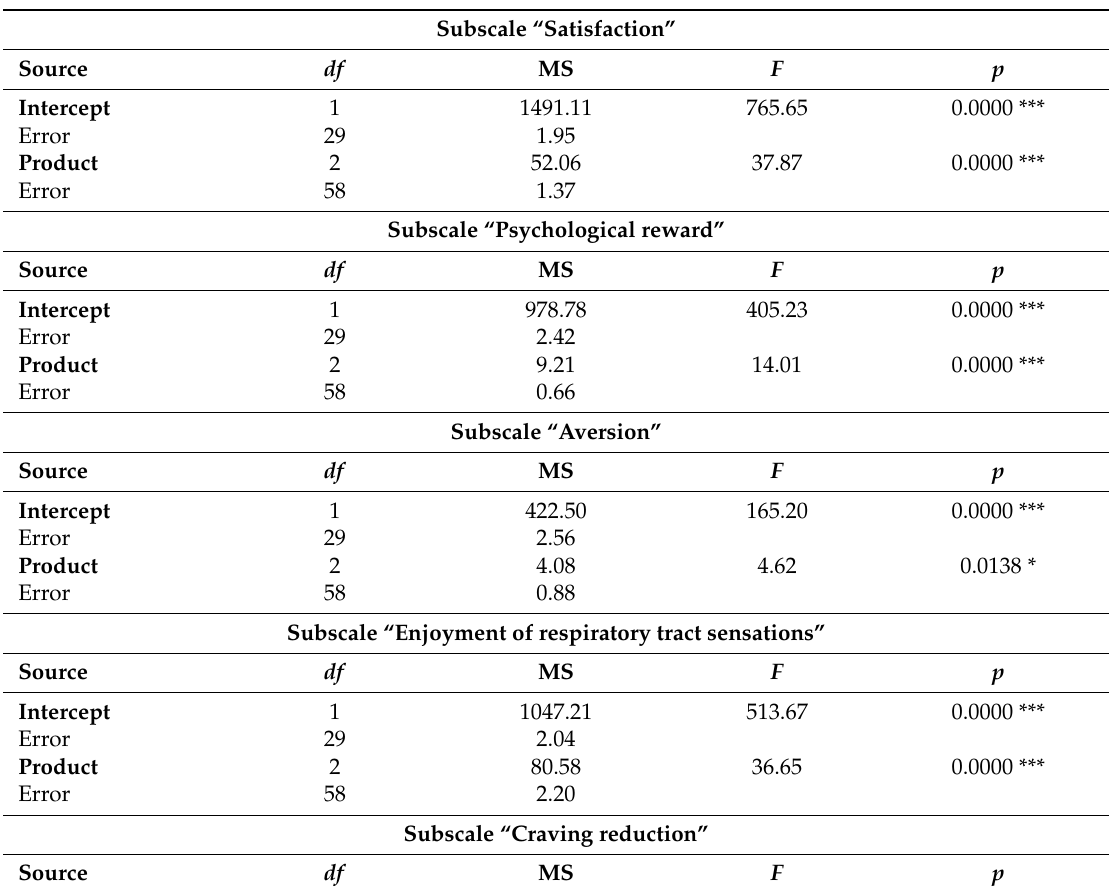
Table A5. ANOVA summary table for mCEQ.